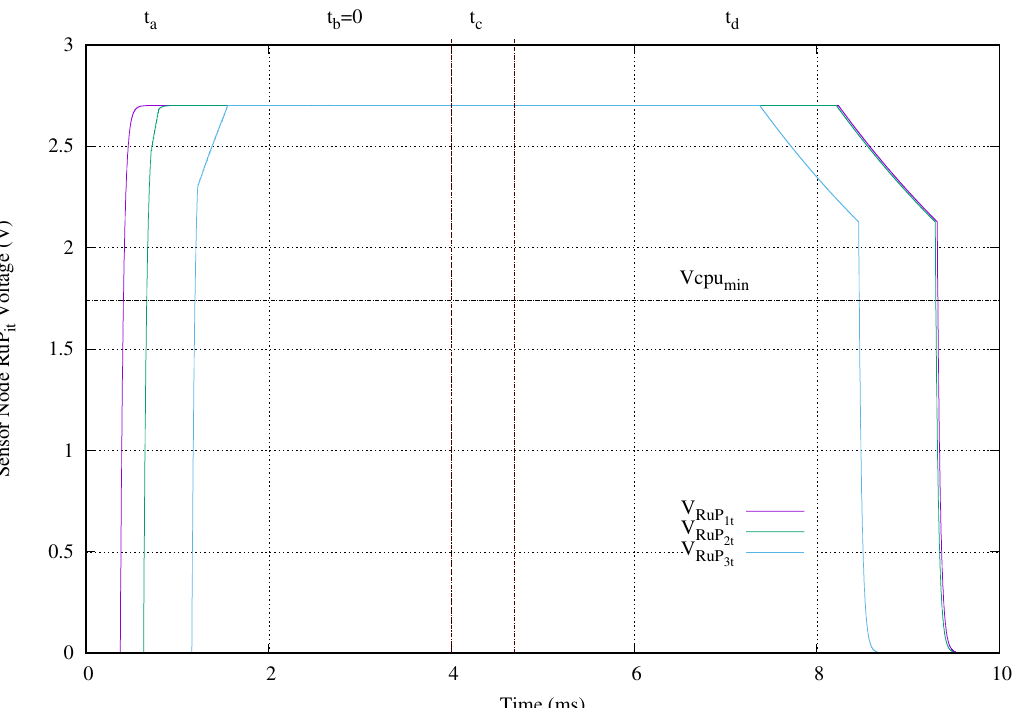
Figure 15. Microcontroller voltage ( V RuP is a cable breakage at C 4